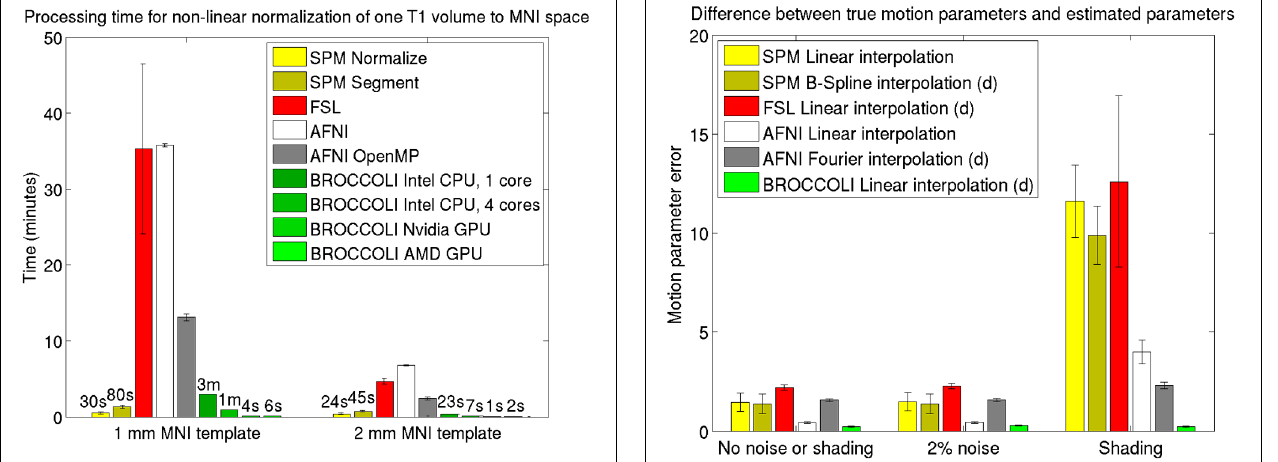
FIGURE 5 | Processing times for non-linear spatial normalization of one T1 volume of size 192 × 192 × 144 voxels to a MNI template (1 and 2mm 3 resolution) for the different software packages, averaged over 198 T1 volumes. The error bars represent the standard deviation. Note that AFNI uses a combination of cubic, quintic, and sinc interpolation as default, while SPM, FSL, and BROCCOLI all use linear interpolation as default. A linear registration was first applied to achieve a good starting point for the non-linear registration. BROCCOLI running on a GPU can perform non-linear normalization to a 1mm 3 template in 4–6s, and still provide a satisfactory result. BROCCOLI running on a CPU is also significantly faster than FSL and AFNI OpenMP, even if a single CPU core is used.